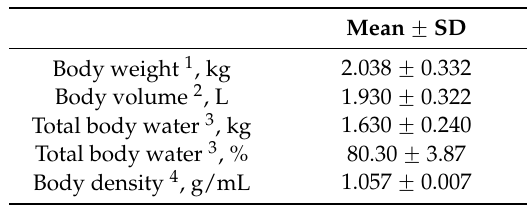
Table 2. Body weight, body volume, total body water and body density of 14 moderately premature infants at the age of 3–7 days.